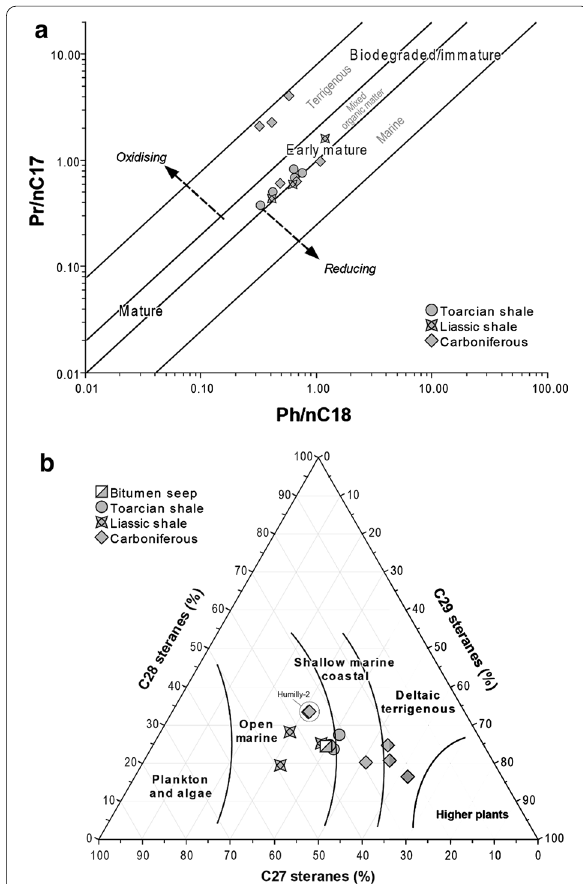
Fig. 7 Biomarker diagrams: a Cross-plot of pristane/n-C17 versus phytane/n-C18 (after Hunt 1996); b Ternary diagram showing the relative abundances of C27, C28, and C29 regular steranes for Lower Jurassic and Carboniferous samples and the Roulave bitumen seep. The sterane composition of the bitumen seep from the Roulave stream indicates a marine origin, equivalent to the composition of the Lower Jurassic